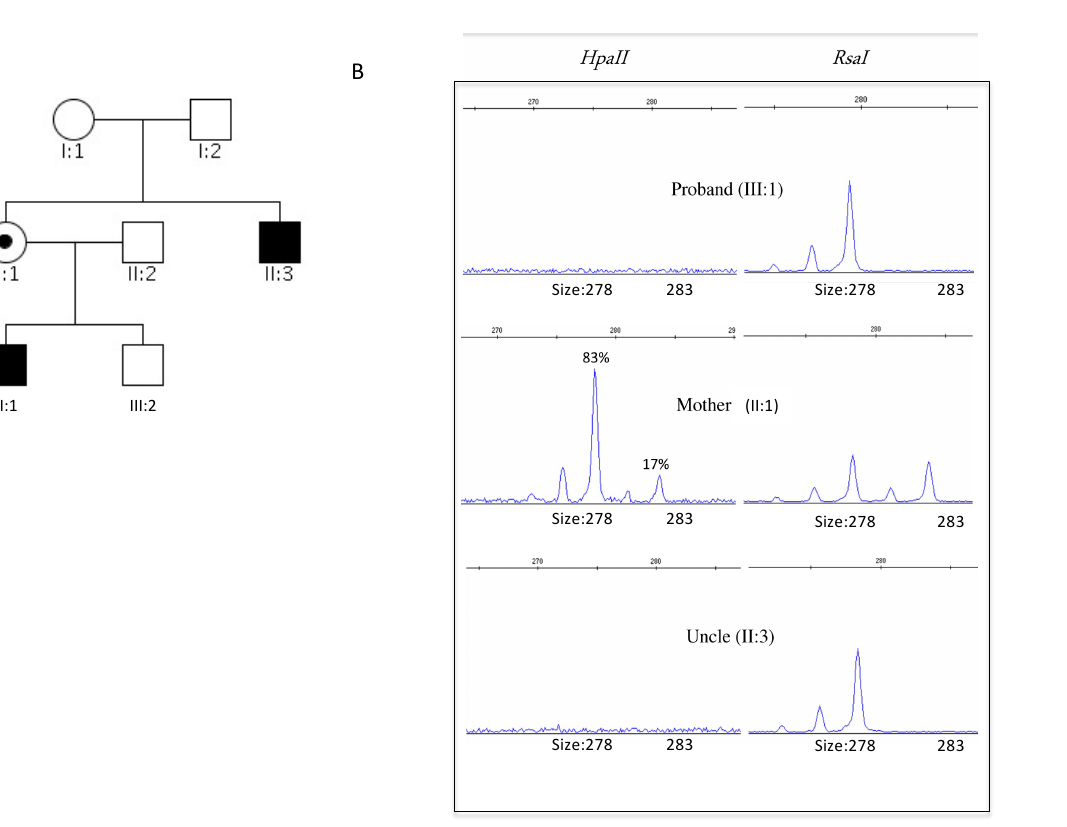
Fig.1 Figure 1. ( A ) The three-generation pedigree for the Italian family affected by intellectual disability. The arrow indicates the proband. ( B ) Analysis of the human polymorphic marker in genomic DNA (from blood cells) digested with HpaII and RsaI